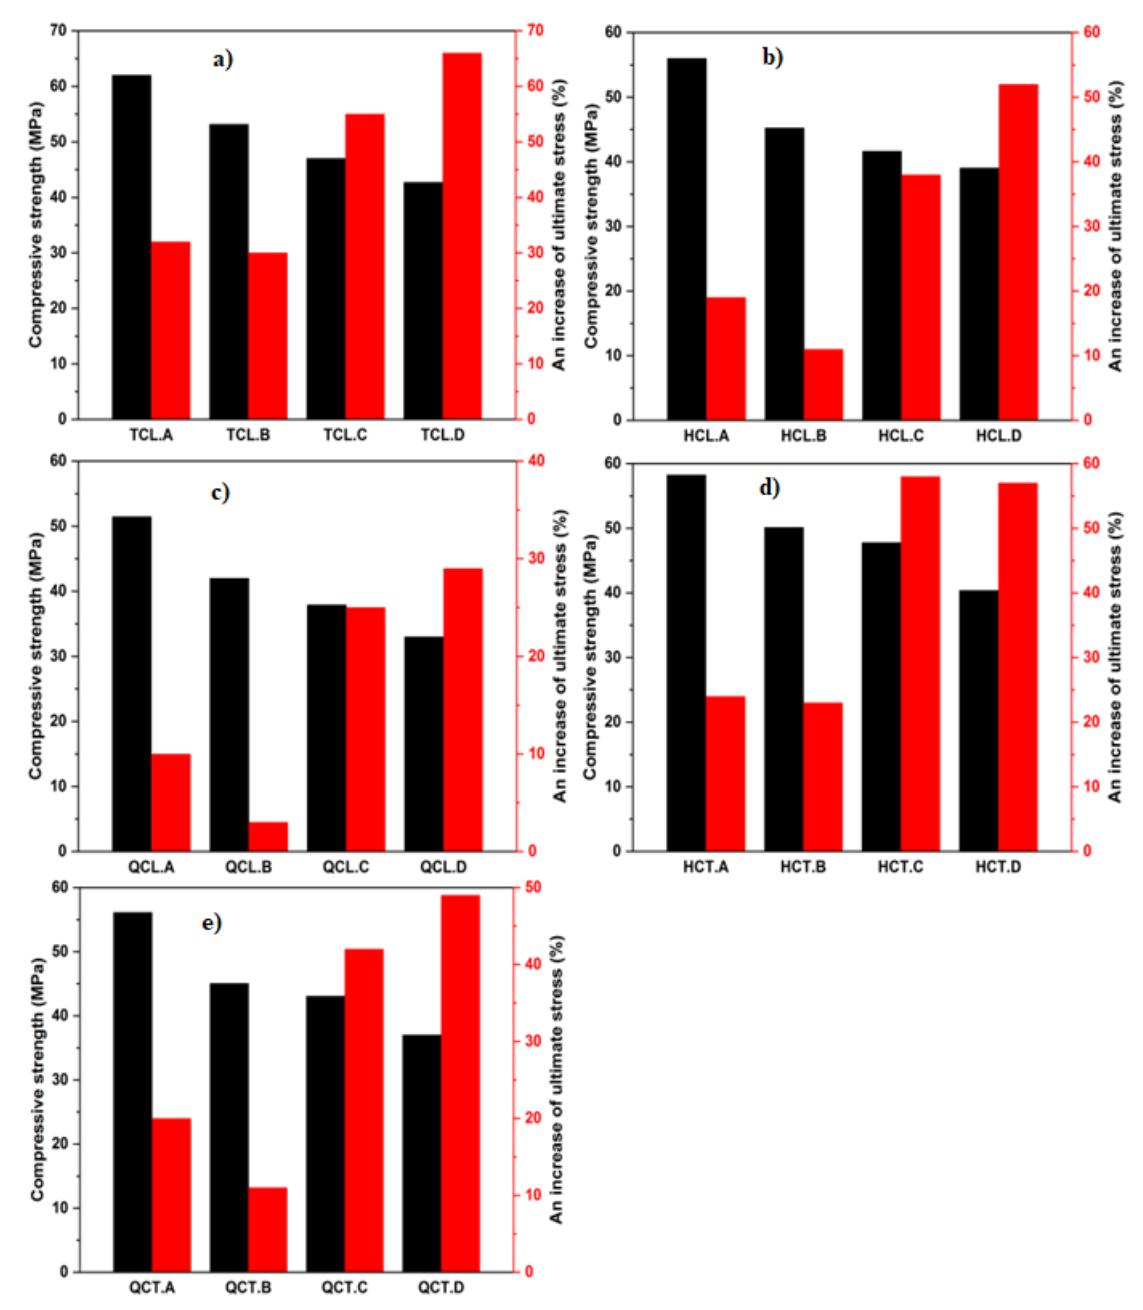
Figure 6. Effect of changing concrete strength: ( a ) TCL configuration; ( b ) HCL configuration; ( c ) QCL configuration; ( d ) HCT configuration; and ( e ) QCT configuration.